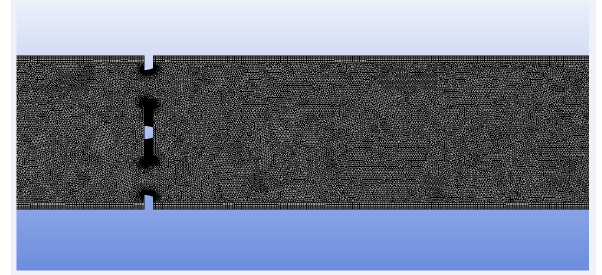
Figure 8: Increased density of nonstructural mesh with a boundary layer for a multi-nozzle